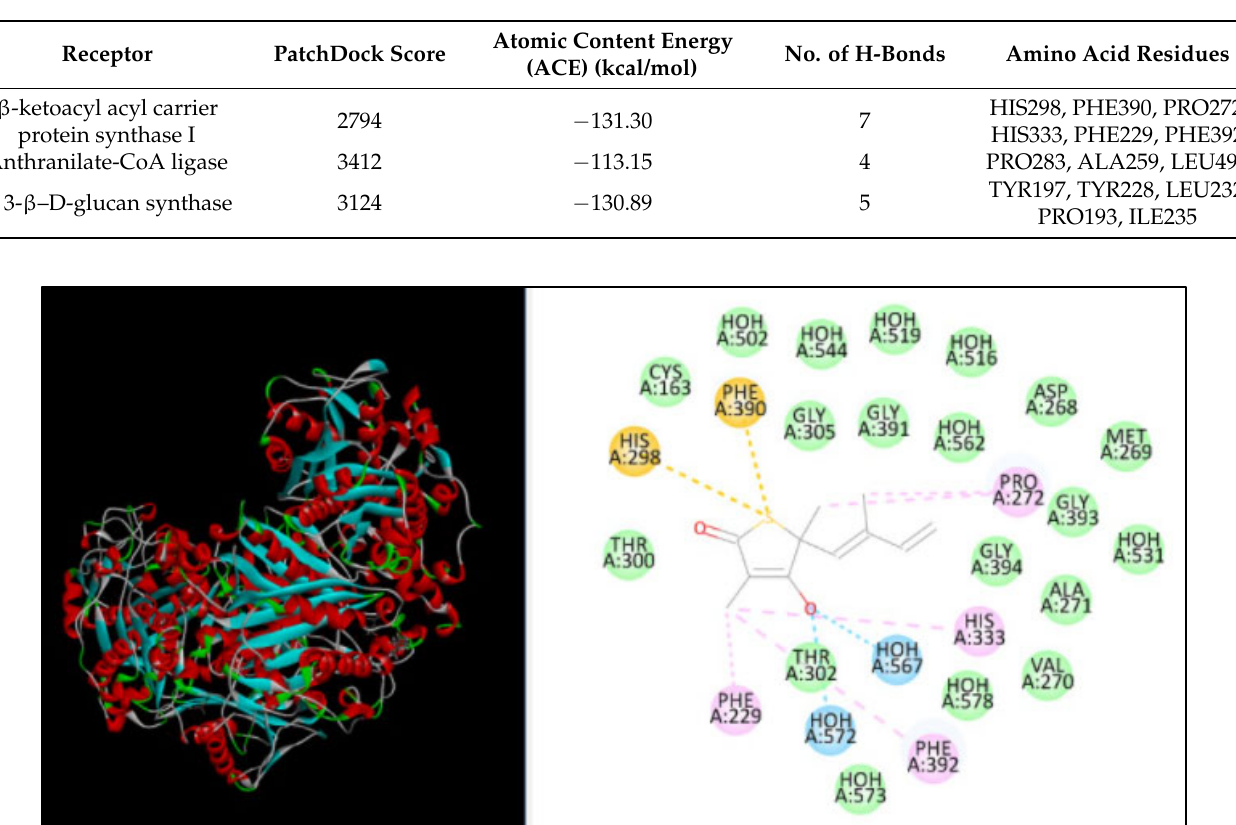
Figure 5. Interaction of Anthranilate ‐ CoA ligase with fenchone.